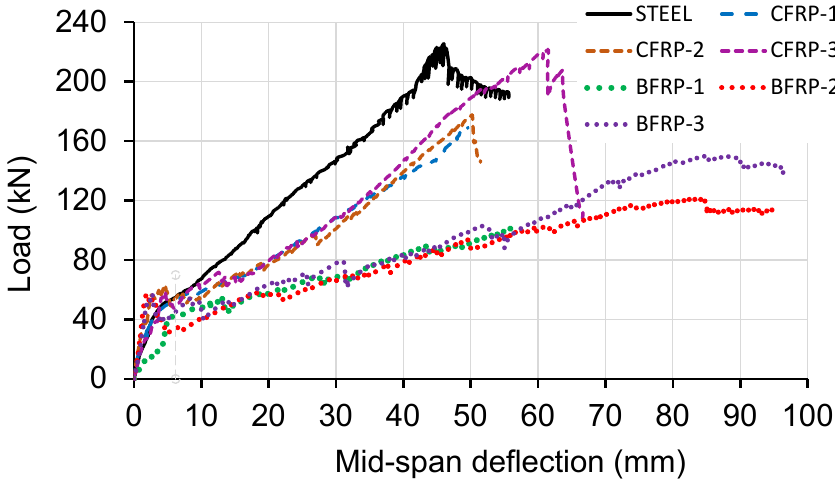
Figure 6. Load vs. mid-span deflection curves for all concrete slabs.